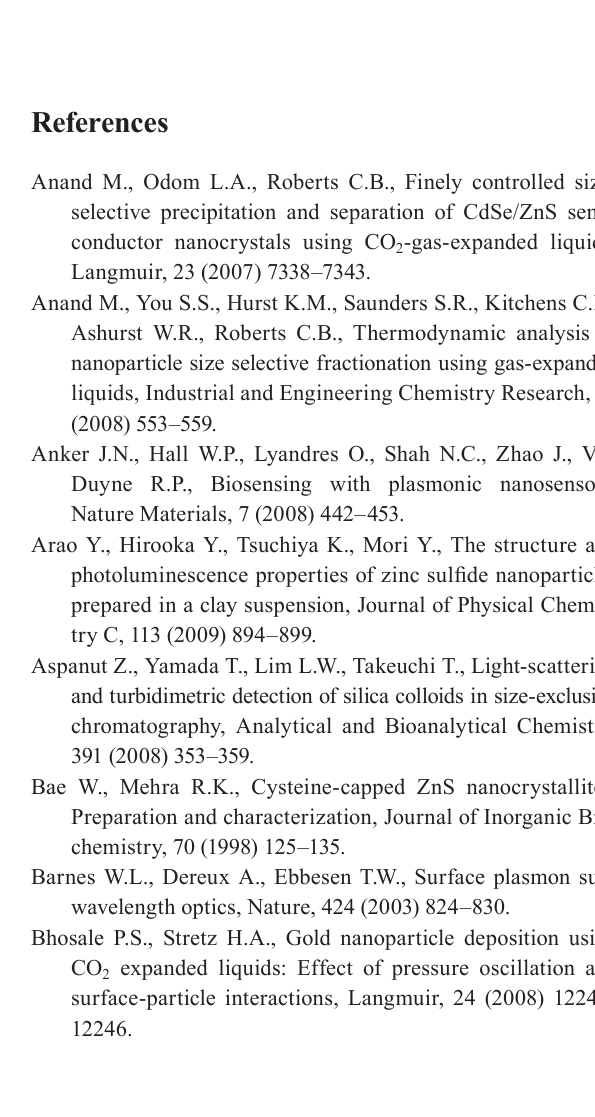
TOPO: trioctylphosphine oxide, TOP: trioctylphosphine, 1-HDA: 1-hexadecylamine, 1-TG: 1-thioglycerol, TGA: thio- glycolic acid, 2-ME: